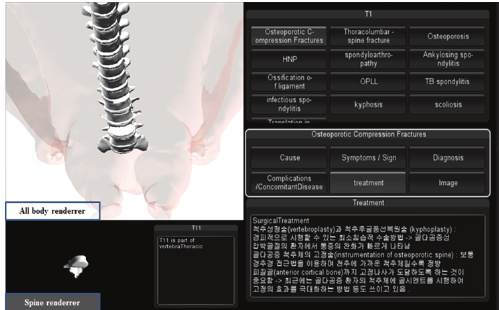
Figure 3: User interface of the proposed